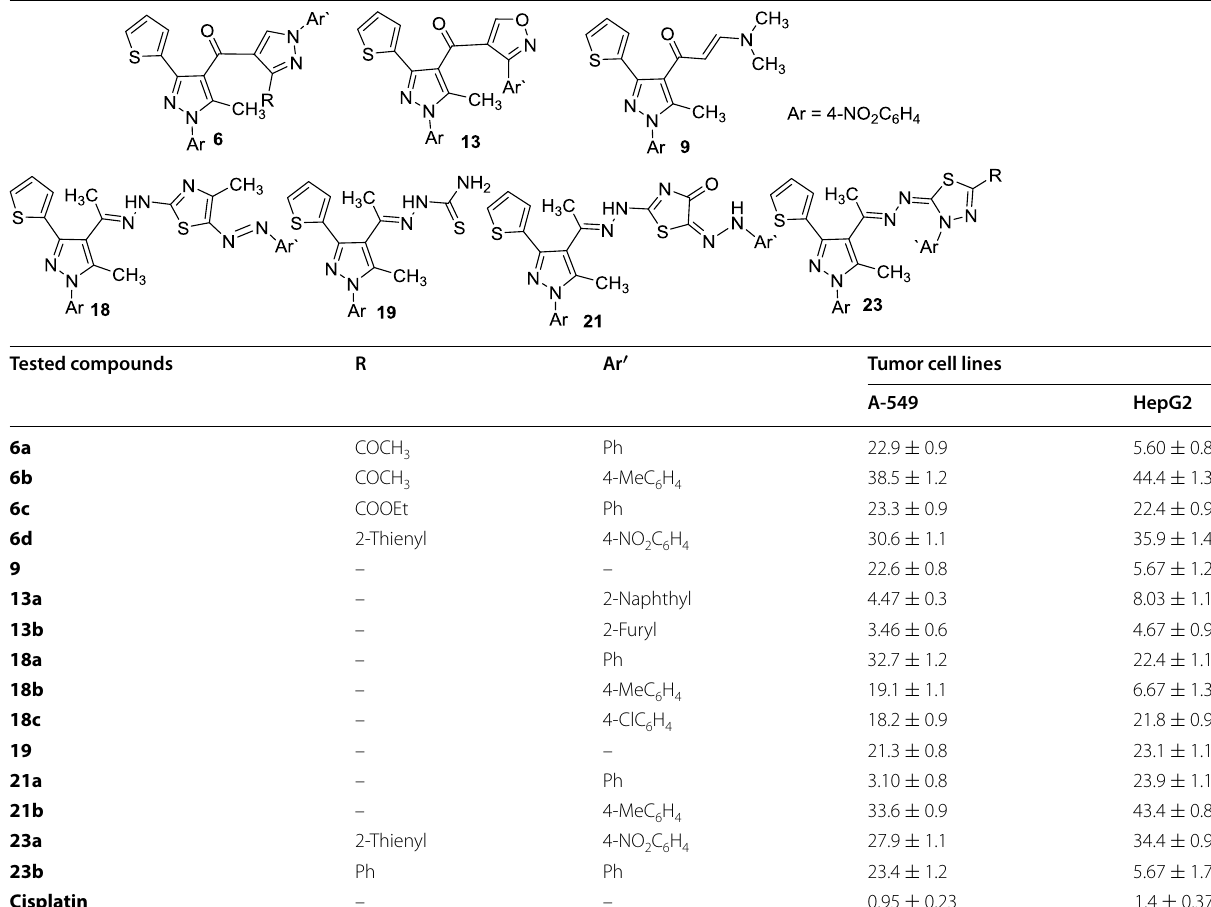
Table 2 The in vitro inhibitory activity of tested compounds against tumor cell lines expressed as IC50 values (μg/mL) standard deviation from three replicates ±